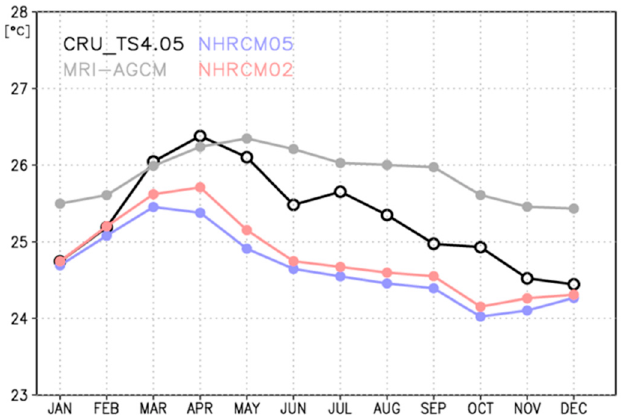
Figure 3. Seasonal changes in 20-year mean monthly surface air temperatures averaged over grids with altitude below 1000 m. Black, gray, blue, and red lines represent observations, MRI-AGCM, NHRCM05, and NHRCM02, respectively.